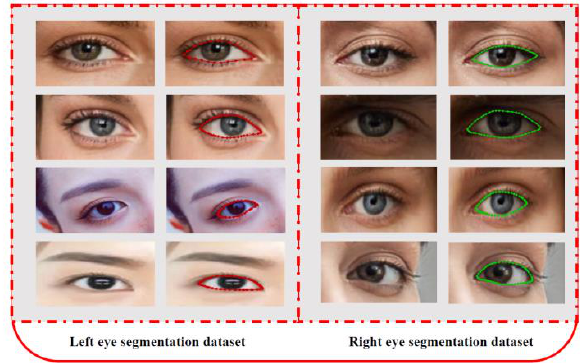
8 of 20 Figure 7. Directory of the eye image segmentation dataset. The images of the left and right eyes cropped from the original eye image are shown in Figure 8 as follows. (1) The characteristics of the left and right eyes were defined, and the images of the eyes